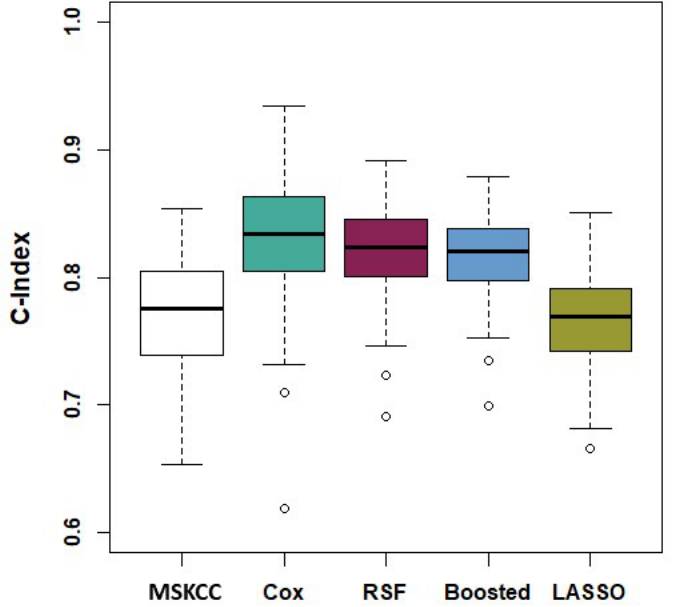
Figure 1. Bootstrap C-Index distributions of the MSKCC nomogram and the most competitive model pipelines using mRNA data. From left to right ; MSKCC, Cox model with clinical variables and correlation prefiltered mRNA variables, RSF model with clinical variables and correlation prefiltered and univariate Cox feature selected mRNA, Boosted Cox model with clinical variables and correlation prefiltered mRNA variables, LASSO Cox model with clinical variables and univariate Cox feature selected